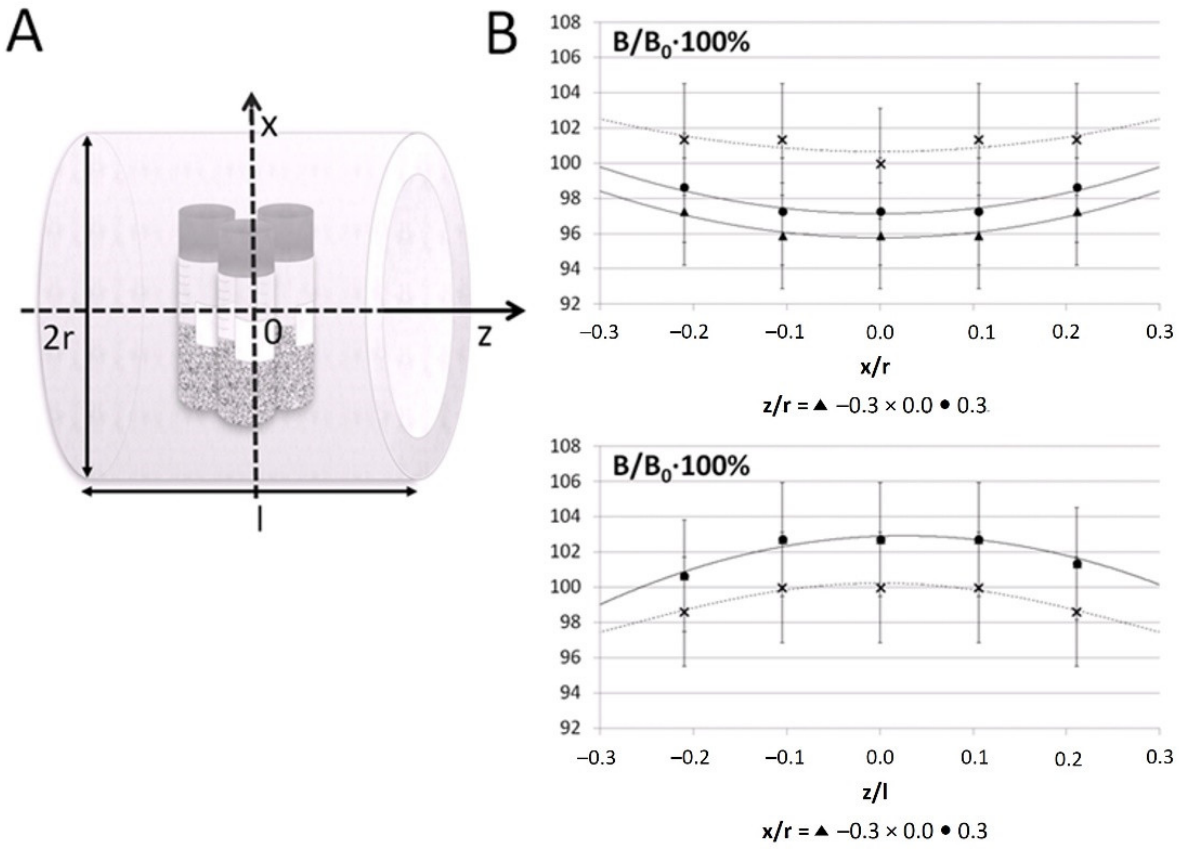
Figure 2. Exposure system: ( A ) The coordinate system; ( B ) The magnetic flux density distribution in solenoid along the z and x axes. B/B 0 is the normalized magnetic flux density relative to the center point of the solenoid, x/r is the normalized distance from coils center along x axis, and z/l is the normalized distance from the coils center along the z axis.